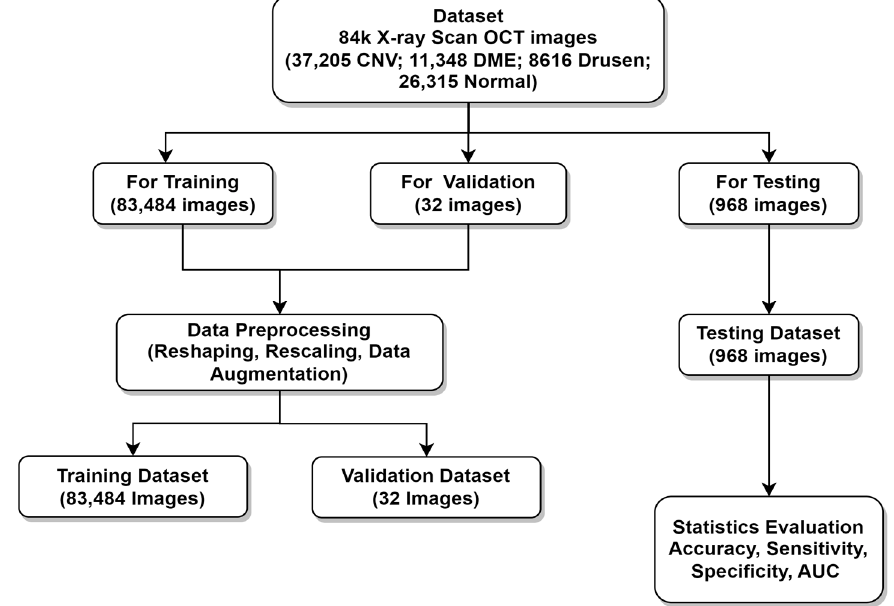
Figure 5. Overall experimental design used in the present research work. Zoom Range = (0.73, 0.9), Horizontal Flip = True, Brightness Range = (0.55,